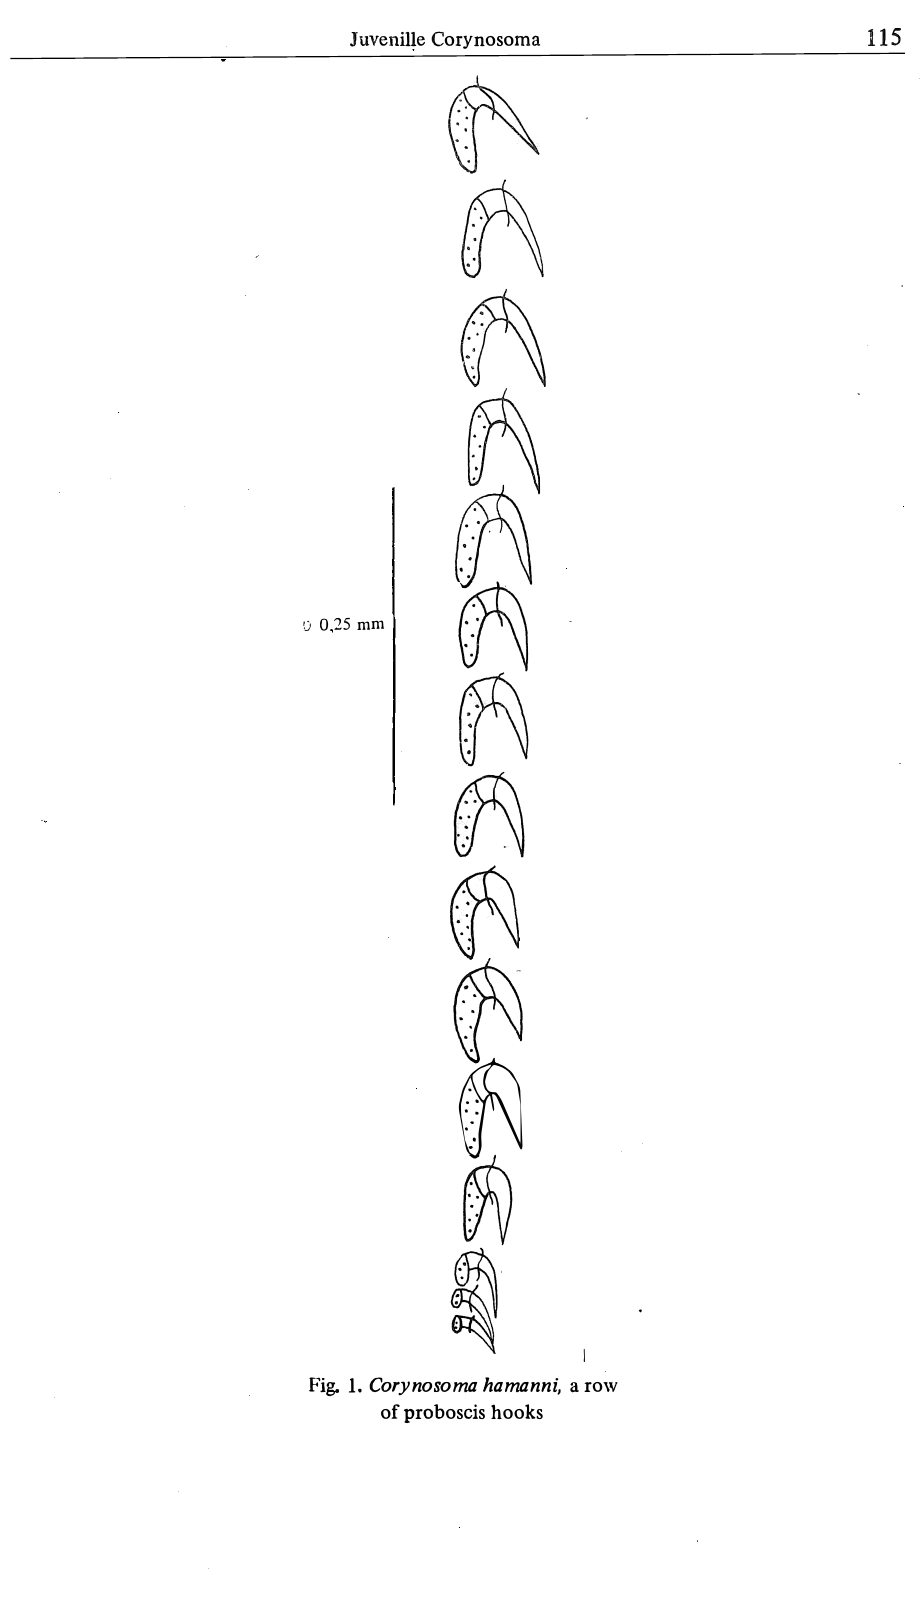
Fig. 1. Corynosoma hamanni, a row of proboscis